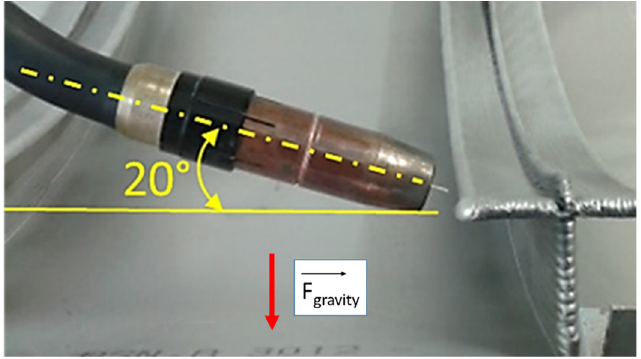
Figure 7. WAAM torch position to manufacture horizontal walls.